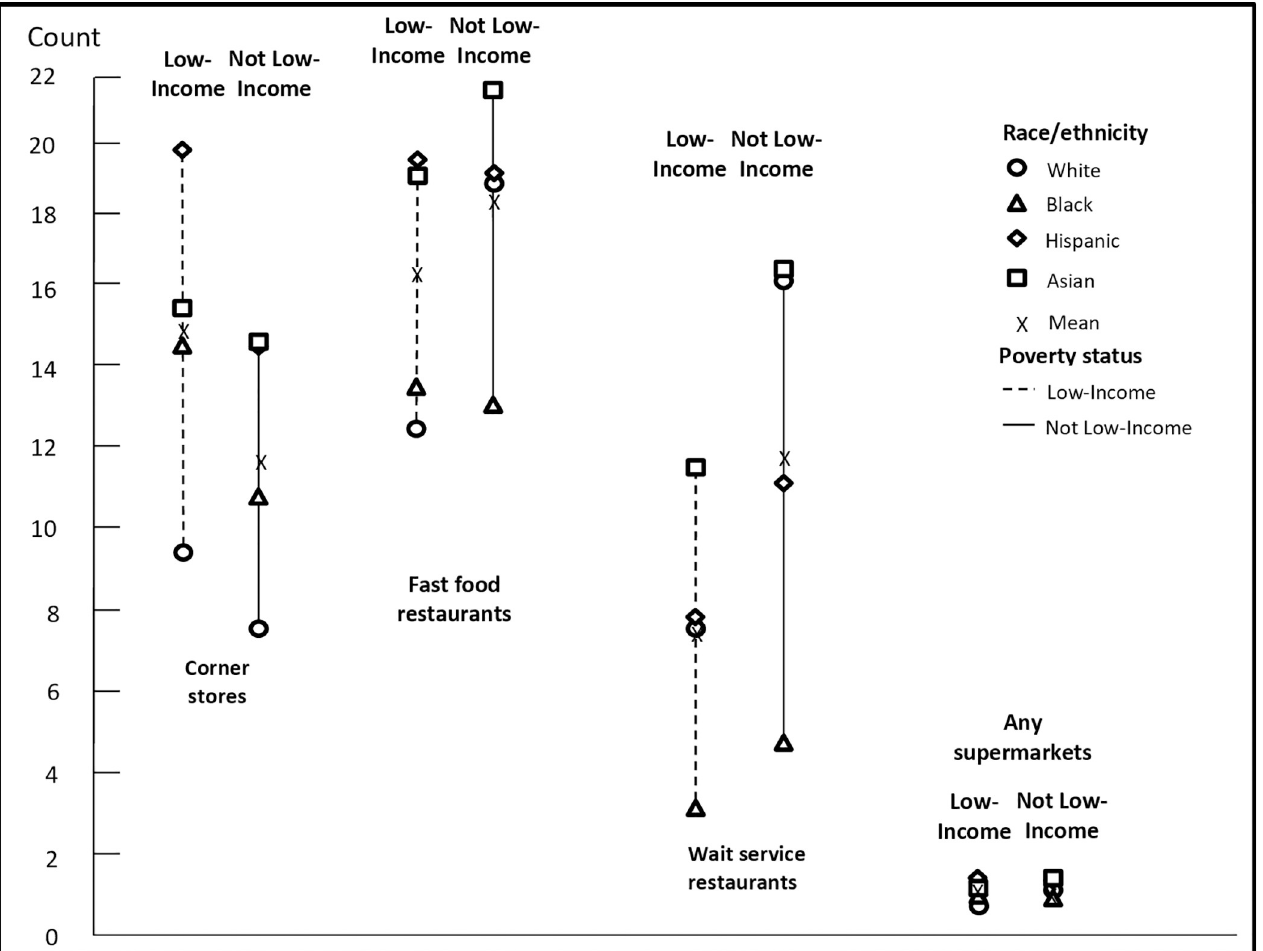
Fig 4. Mean count within 0.25 miles (1,320 ft) of food facilities from home, race and poverty interactions, 2013. We conducted a joint F-test, which suggests significant differences among income and race groups (p < 0.05), and pair-wise T-tests for multiple comparisons based on Bonferroni correction (28 pairs in total, with each pair tested on all four food outlets, separately). The majority of comparisons were statistically significant (p < 0.05). S20 Table presents test results (p-values) for each pair.